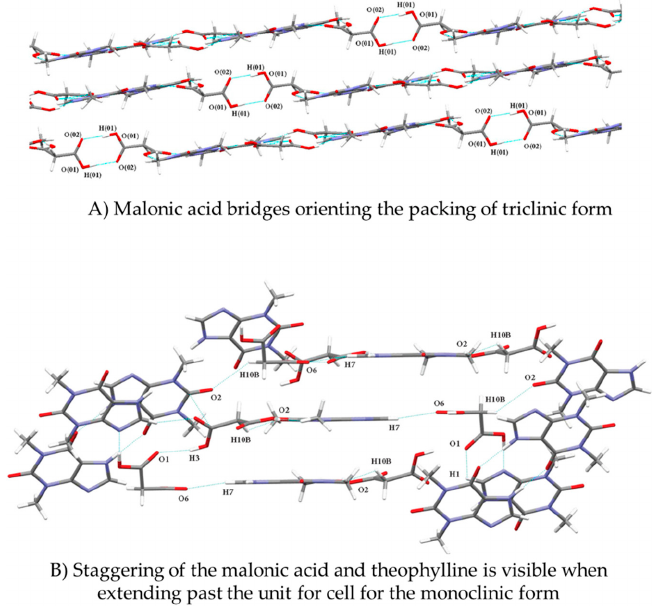
Figure 9. Theophylline-malonic acid co-crystals of ( A ) Triclinic, and ( B ) Monoclinic form, showing the difference in the malonic acid orientation. Reprinted (adapted) with permission from [28]. Copyright 2021, American Chemical Society.